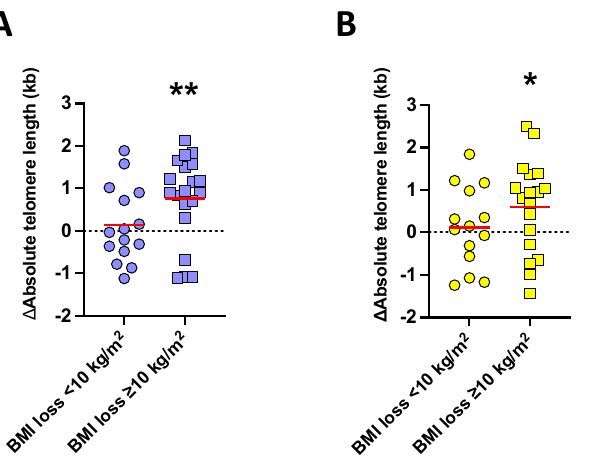
Figure 4. Difference (∆) of the absolute telomere length (TL) of the follow-up population after bariatric surgery (n = 35): ( A ) Lymphocytes (n = 35) and ( B ) granulocytes (n = 32) separated in patients with a body mass index (BMI) loss ≥ 10 kg/m 2 (shown in squares) or < 10 kg/m 2 (shown in circles). Patients with BMI loss ≥ 10 kg/ m 2 had a significant increase of TL in lymphocytes and granulocytes. Data are displayed as mean (red bar). *Significance of P < 0.05, ** P < 0.01 (Student’s